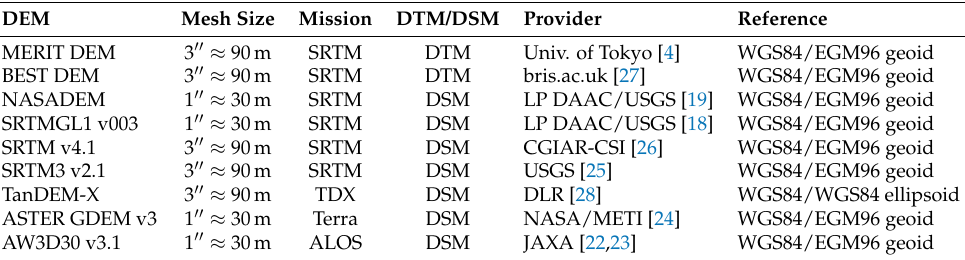
Table 1. Overview of the publicly available global Digital Terrain Models (DTM) and Digital Surface Models (DSM) evaluated for Costa Rica in this study. The column “Mission” here indicates the remote sensing mission that was the principal data source used in the DEM in the study area (latitudes below